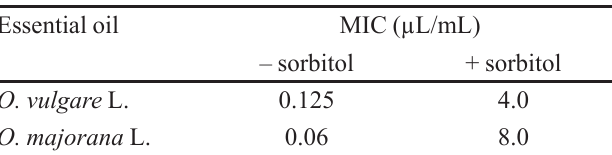
TABLE IV - MIC of the essential oil from O. vulgare L. and O.